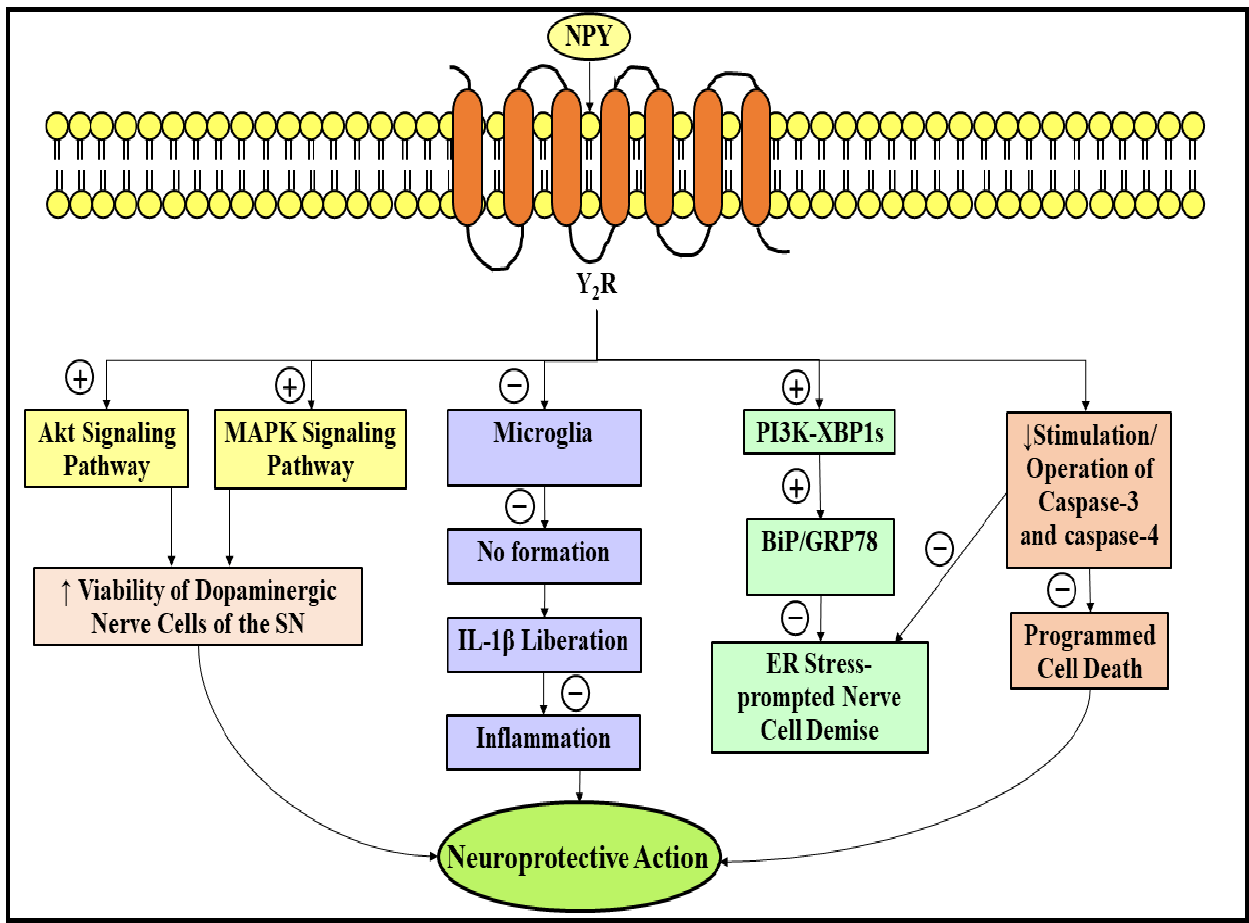
Figure 6. Highlighting the neuroprotective role of neuropeptide Y in Parkinson’s disease. NPY exhibits its significant nerve cell protective action upon interacting with DA-forming cells by means of Y 2 R. NPY stimulates the two, namely the Akt signaling pathway and the MAPK signaling pathway and contributes to the enhanced viability of DA-forming nerve cells of the nigral area of the encephalon. In addition, NPY exerts its nerve cell protective action by suppressing the microglia, which in turn suppresses the NO formation and IL-1 β liberation, and finally results in the suppression of inflammation. Furthermore, NPY, via stimulating the PI3K-XBP1s-Bip/GRP78 signaling pathway, suppresses the ER stress-provoked nerve cell demise, and ultimately contributes to neuroprotection. Moreover, therapy with the assistance of NPY de-escalated the stimulation/operation of caspase-3 and caspase-4, which consequently suppressed the programmed cell death and ER stress-triggered nerve cell demise and contributed to nerve cell protection in PD. Subtraction symbol indicates inhibitory/suppressing action, while addition symbol indicates stimulatory action. NPY, neuropeptide Y; Y 2 R,Y 2 receptor; DArgic, dopaminergic; SN, substantia nigra; MAPK, mitogen-activated protein kinase; NO, nitric oxide; IL-1 β , interleukin-1 β ; PI3K, phosphoinositide 3-kinase; XBP1s, spliced form of X-box binding protein 1; BiP, binding immunoglobulin protein; GRP78, 78-kDa glucose-regulated protein; ER stress, endoplasmic reticulum stress; DA, dopamine; PD, Parkinson’s disease; ↑ , increasing; ↓ , decreasing. 3.4. Neurprotective Role of Neurotensin in Parkinson’s Disease Neurotensin, an NP comprehending thirteen amino acid units, was initially originated nearly 49 years ago from the calf hypothalamus by two prestigious researchers, namely Robert Carraway and Susan E. Leeman, and denominated owing to its localization in the nerve cells and hypotensive action (blood pressure-decreasing aptitude) [175,176]. The amino acid sequence of neurotensin is as follows: pyr-Glu-Leu-Tyr-Glu-Asn-Lys-Pro- Arg-Arg-Pro-Tyr-Ile-Leu-OH (Table 1) [177]. This modulatory endogenous peptide is pinpointed in two regions, i.e., the CNS (principally the pituitary and hypothalamus) and